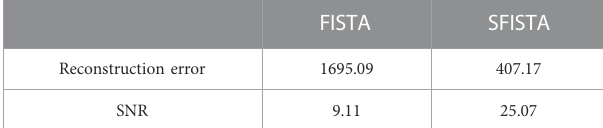
TABLE 3 Reconstruction error and SNR of different methods.